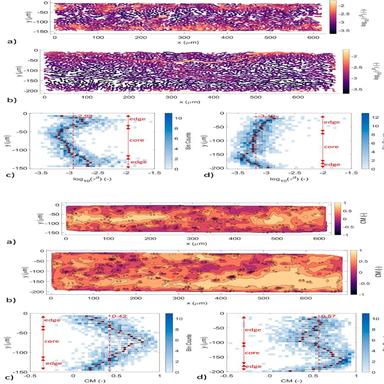
Projection of the fibre paths on a single crosssection orthogonal to the tape axis, colour - coded according to the logarithm of differential tortuosity (τd ), for a) Tape A b) Tape B; bin scatter plot of the logarithm of differential tortuosity along the tape thickness for c) Tape A d) Tape B. The dashed line represents the median value of the logarithm of differential tortuosity calculated over the full crosssection, which value is noted at the top of each graph. For each horizontal bin, the local median